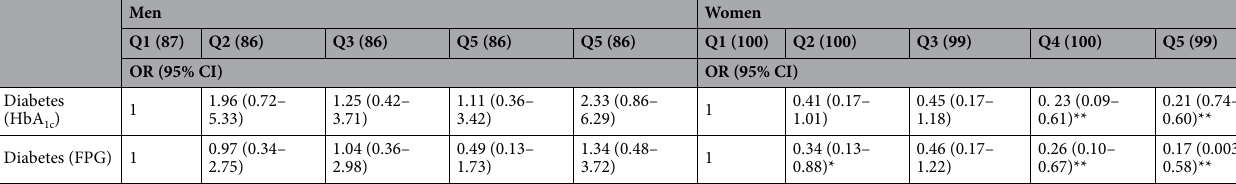
Table 3. Odds of having diabetes across pSAA activity quintiles using logistic regression adjusted for age and BMI. Diabetes was defined either with HbA1 c or FPG cutoff. The **indicate significance (1% level) relative to